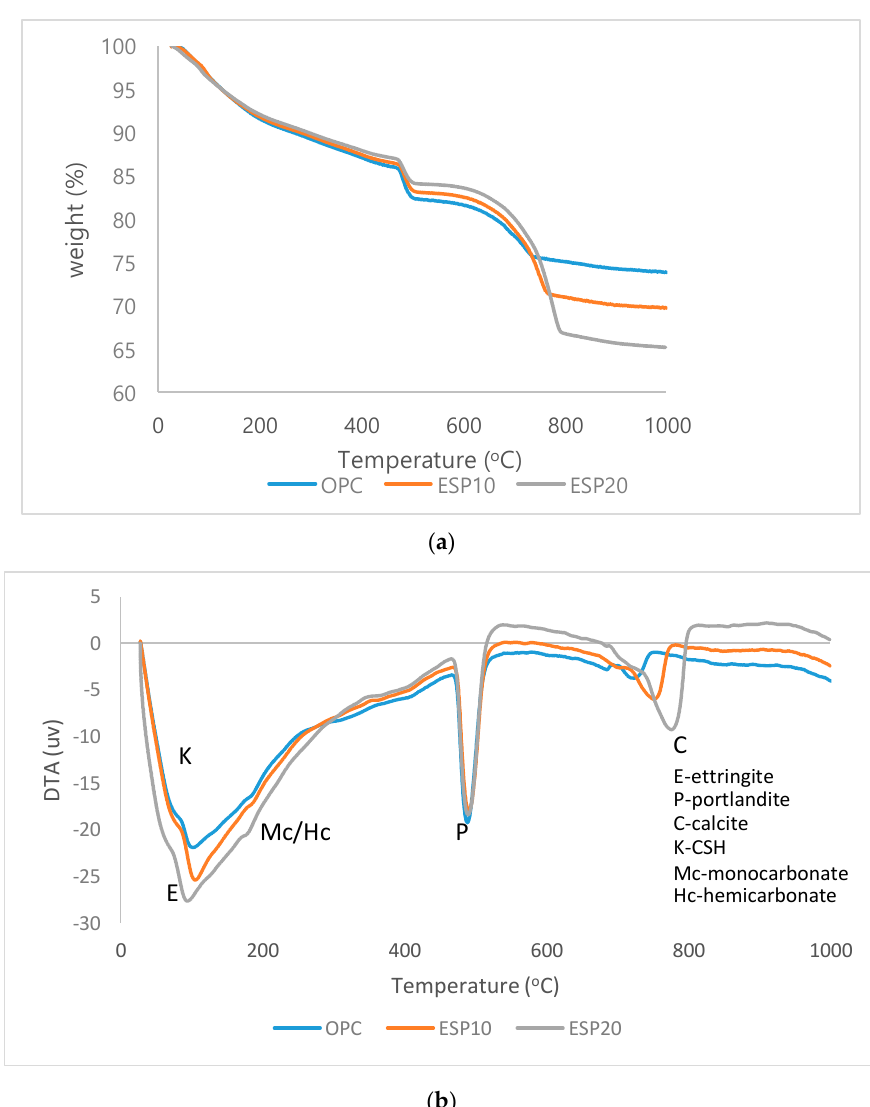
Figure 9. ( a ) TGA result of 28-day cement paste; ( b ) DTA result of 28-day cement paste.